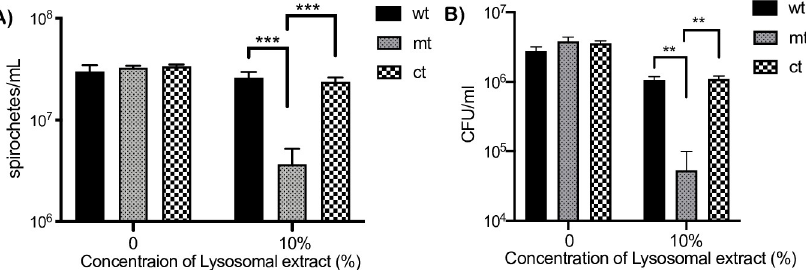
Fig 12. Sensitivity of bpiP mt to lysosomal extracts. All three strains (wt, mt, ct) were seeded at a density of 1 × 10 6 spirochetes in 1ml BSKII media with or without 10% lysosomal extract obtained from murine bone marrow derived dendritic cells as described in the Materials and Methods section and incubated at 37˚C, 1% CO 2 for five days. (A) Spirochetes were enumerated every 24 hours and data shown is for the number of spirochetes/ml after 5 days of treatment. ( B ) Colony forming units of cultures with 0 or 10% lysosomal extract at day 5 post-treatment were determined by diluting cultures of all three strains to 1:100,000 in 1X BSKII medium, plated on BSKII agar overlays and the final CFU/ml of the treated cultures were calculated after 10 days of incubation at 32˚C with 1% CO 2 . One of two independent experiments is shown. Statistical analysis of differences in the number of spirochetes between treated and untreated cultures were determined by unpaired t test. The asterisks indicate levels of significance as follows: ��� , p < 0.001; �� , p <